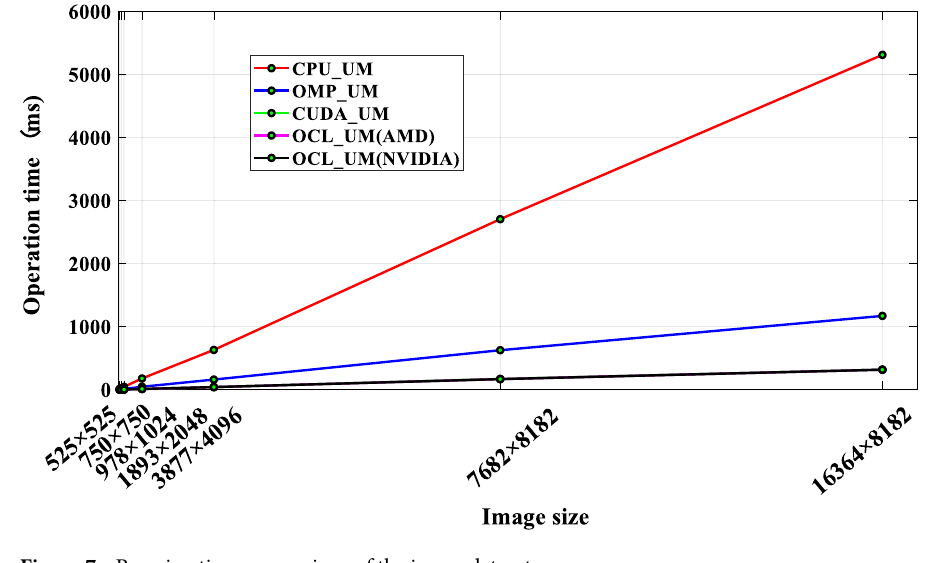
Figure 7. Running time comparison of the image